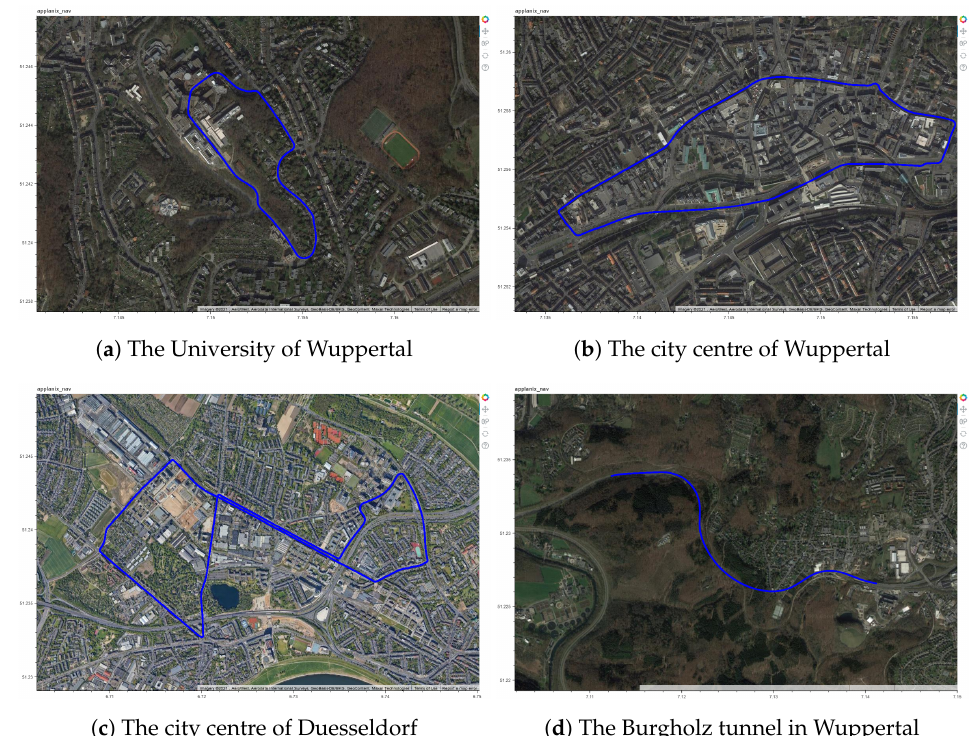
Figure 3. The selected test regions for performance analysis.